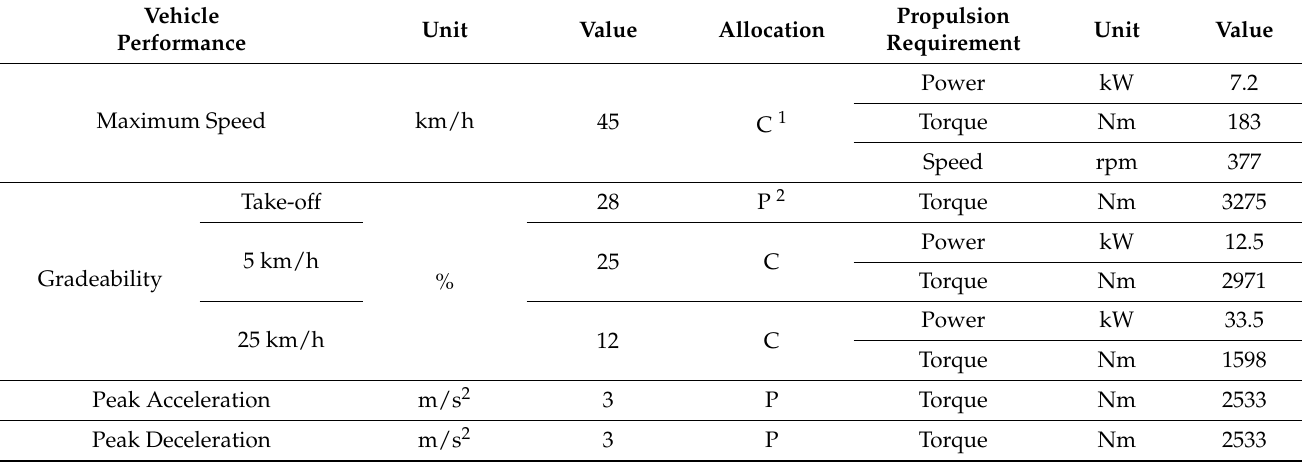
Table 3. Propulsion system requirements corresponding to vehicle performance.